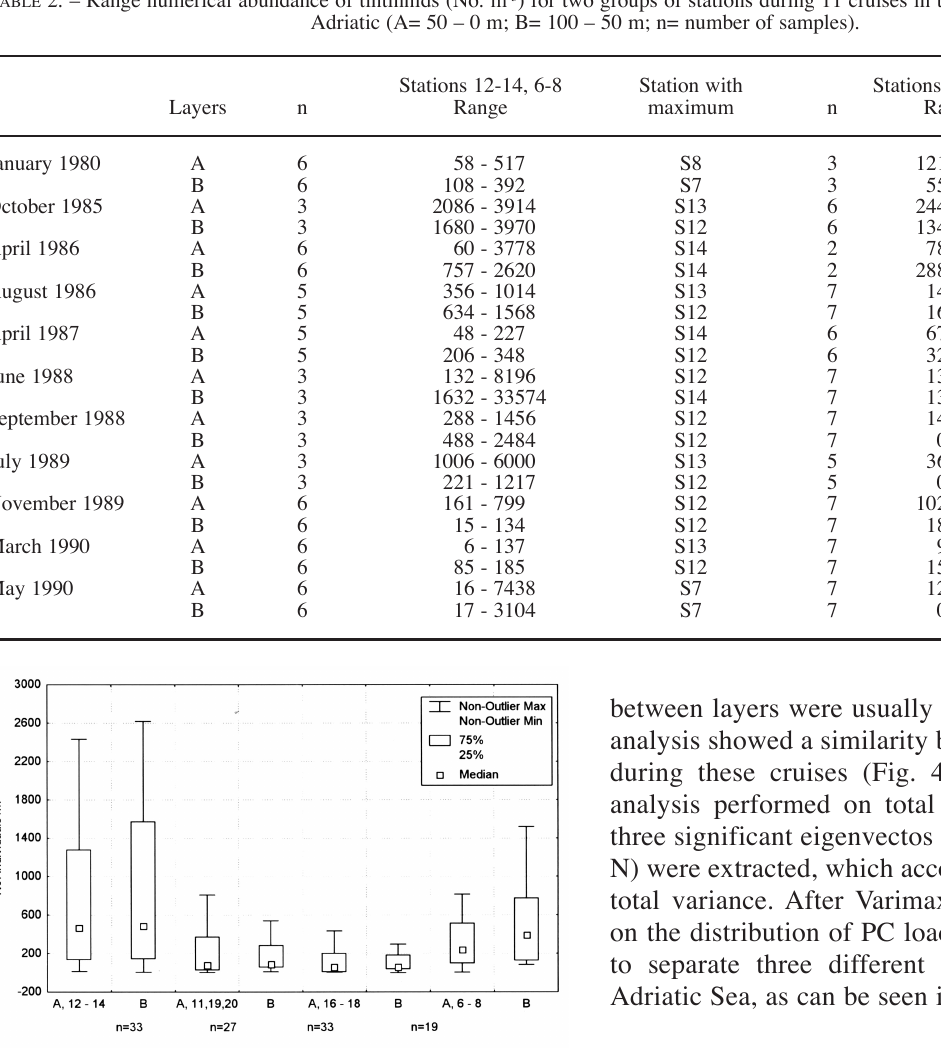
F IG . 3. – Box diagram of non-transformed data for the total number of tintinnids in layers A, 0-50 m; B, 50-100 m for four different